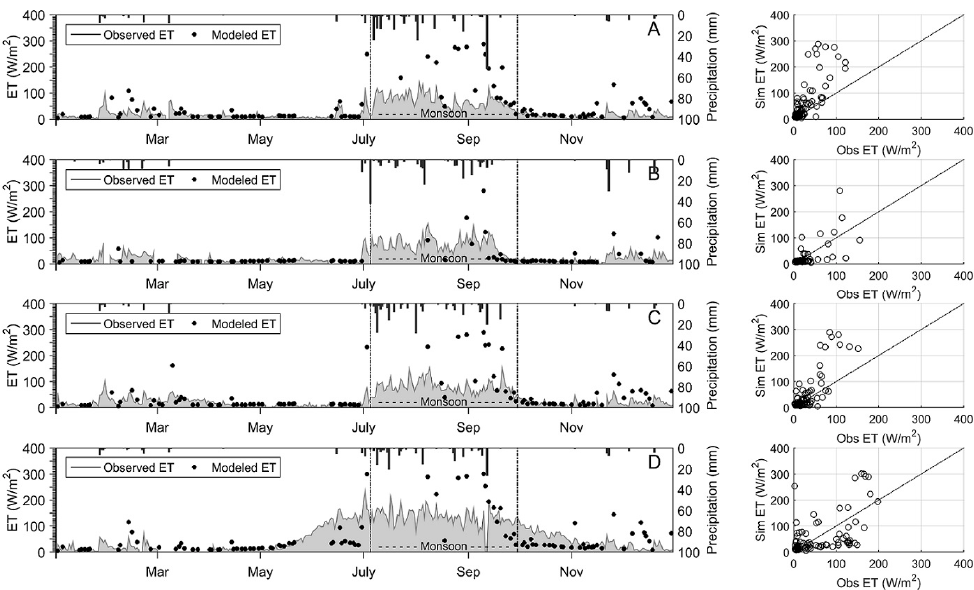
Figure 6. Comparison between modeled ET (W/m 2 ) and observed ET (W/m 2 ) for sites: Whs ( A ); SRM ( B ); Wkg ( C ); and CMW ( D ) for the year